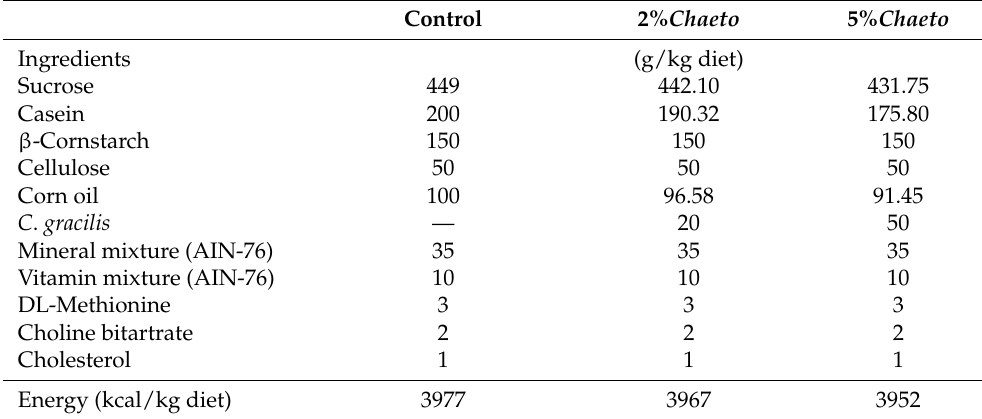
Table 2. Composition of experimental diets in the present